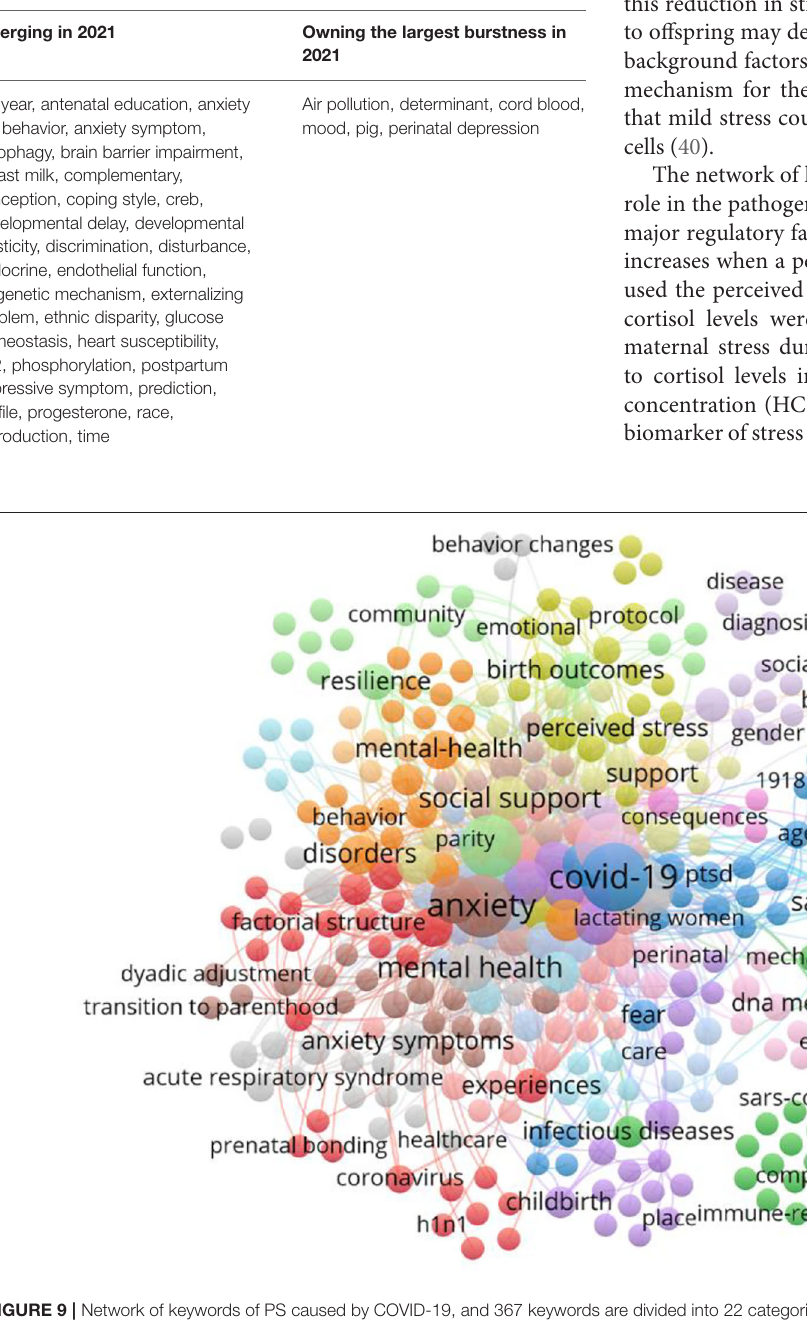
Frontiers in Pediatrics |